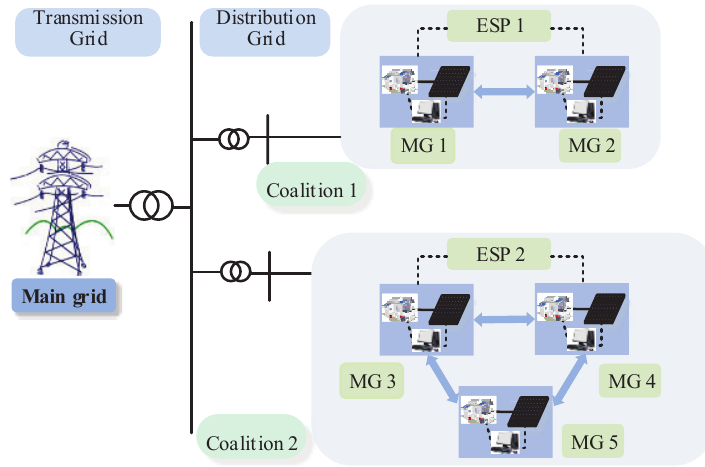
Figure 1. An illustration of the studied system structure with coalitions of microgrids (MGs). ESP: energy sharing